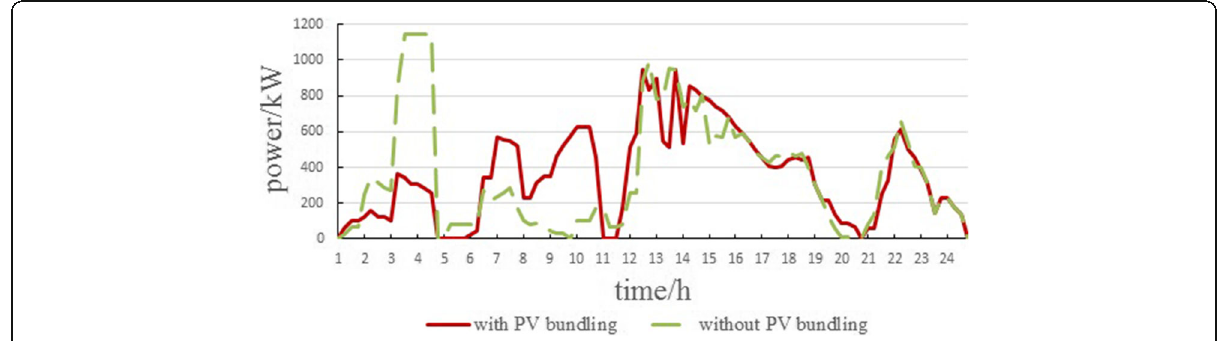
Fig. 5 Charging power curves with and without PV bundling requirements at a workday in Summer